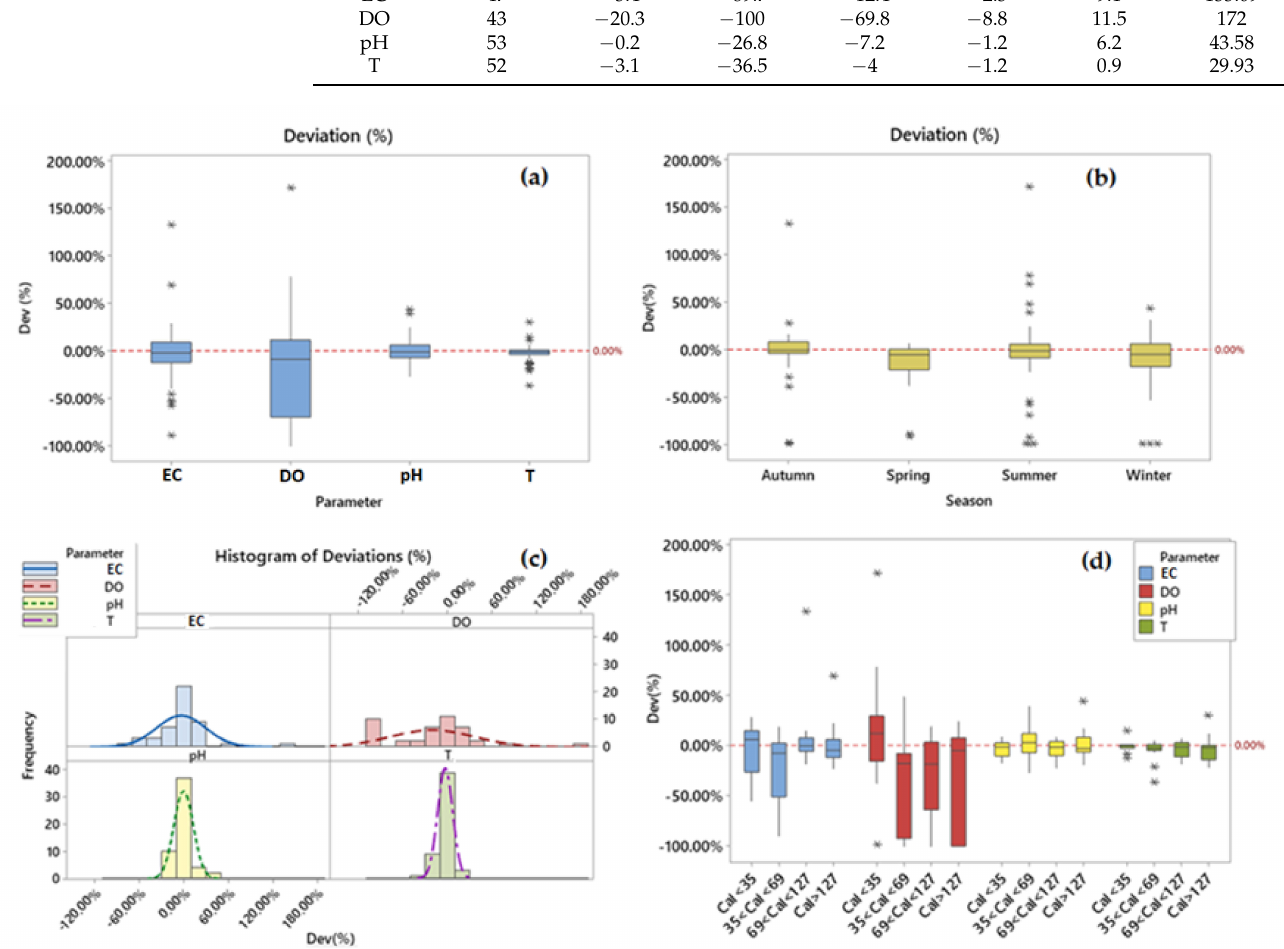
Figure 8. Percentage deviations of automatic station measurements from in situ measurements: ( a ) per water quality parameter: EC (electrical conductivity), DO (dissolved oxygen), pH and T (temperature), ( b ) per season, ( c ) per parameter showing the frequency of each deviation level and ( d ) per parameter and time period (in days) elapsed from the previous on site sensor